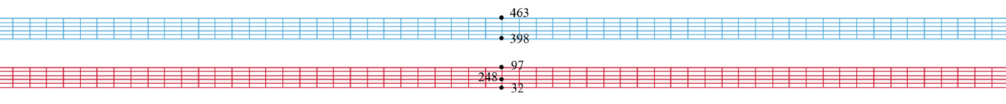
Figure 11. Typical nodes in the thickness direction of the model.